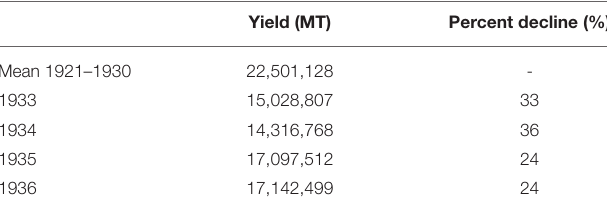
TABLE 1 | US Dust Bowl Wheat Production USDA National Agricultural Statistics Service. Yield (MT) Percent decline